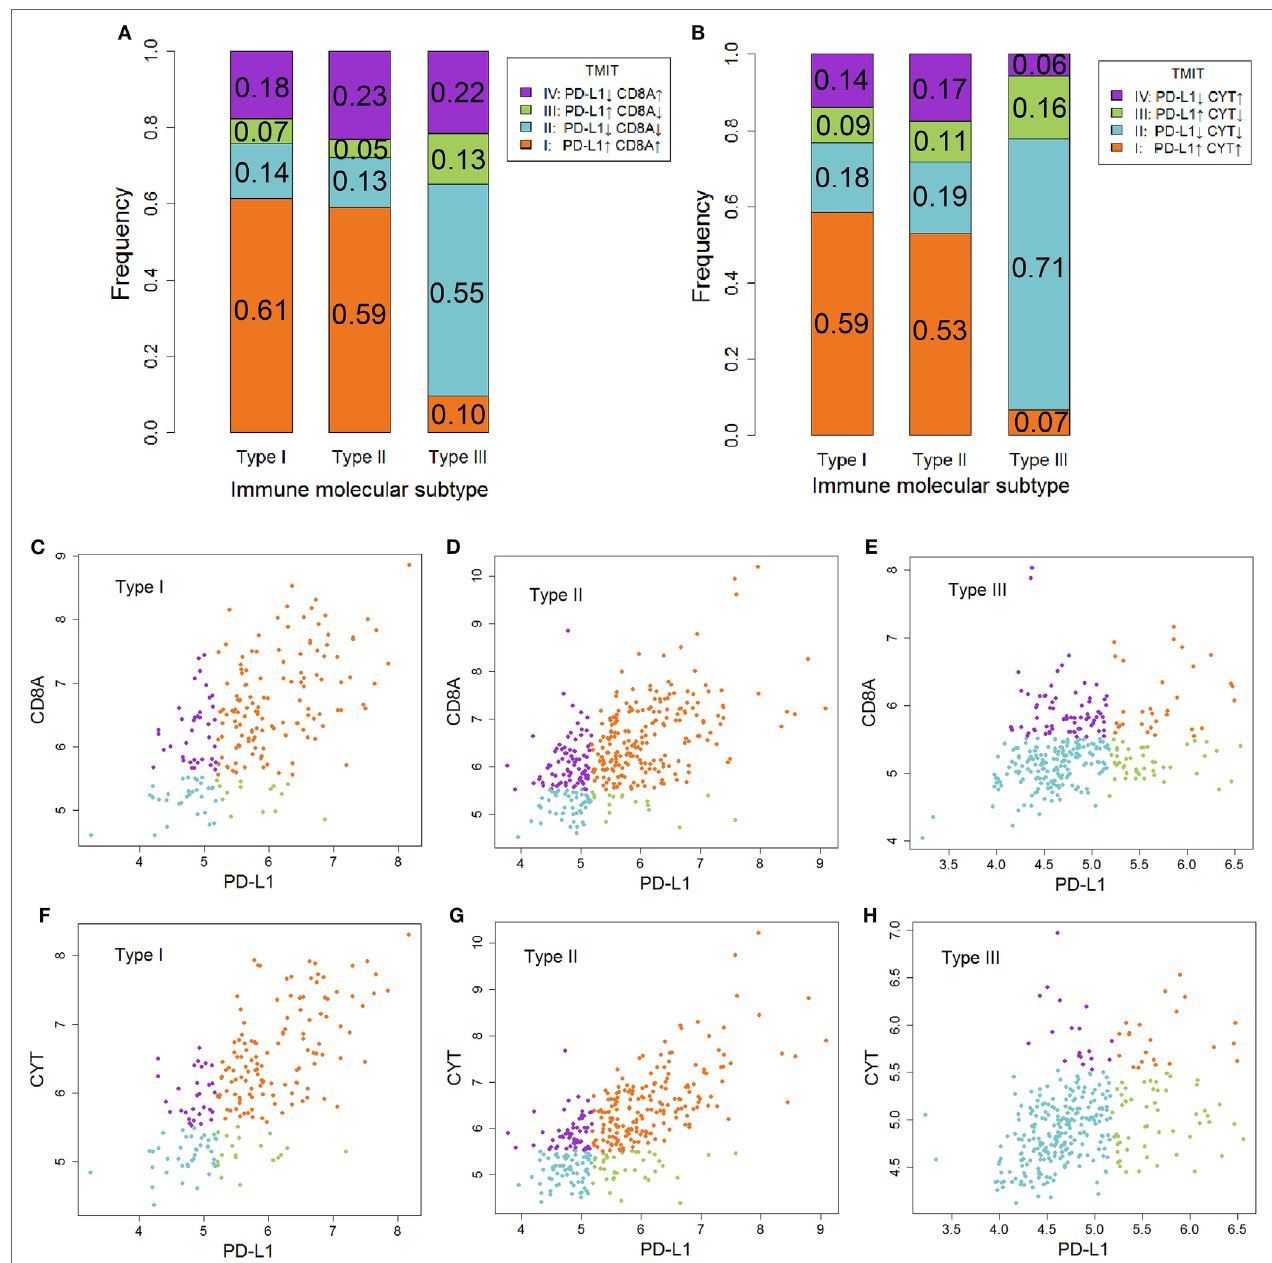
FigUre 4 | The association between immune molecular subtype (IMMS) and tumor microenvironment immune types (TMIT). (a) A summary of four TMITs ( PD-L1 + CD8A ) in three IMMSs. (b) A summary of four TMITs ( PD-L1 + CYT) in three IMMSs. (c) Scatter plot of four TMITs ( PD-L1 + CD8A ) in type I ovarian cancer. (D) Scatter plot of four TMITs ( PD-L1 + CD8A ) in type II ovarian cancer. (e) Scatter plot of four TMITs ( PD-L1 + CD8A ) in type III ovarian cancer. (F) Scatter plot of four TMITs ( PD-L1 + CYT) in type I ovarian cancer. (g) Scatter plot of four TMITs ( PD-L1 + CYT) in type II ovarian cancer. (h) Scatter plot of four TMITs ( PD-L1 + CYT) in type III ovarian